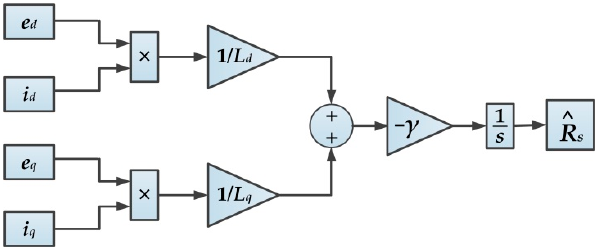
Figure 9. Block diagram for the estimation of R s stator resistances.